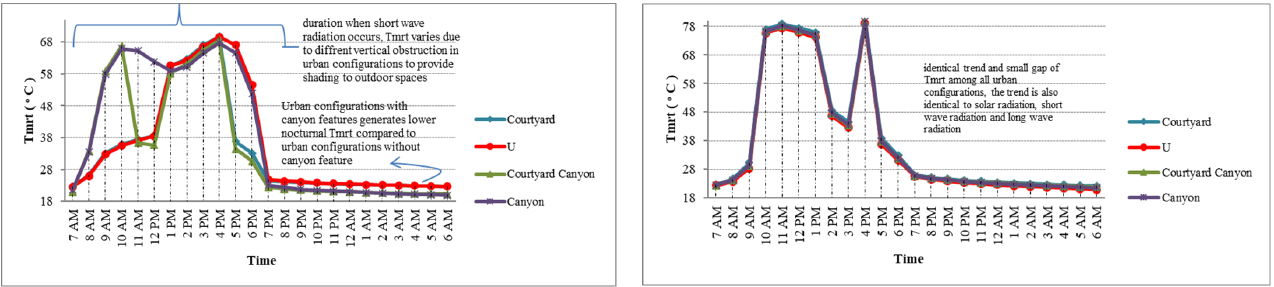
Figure 11. Mean radiant temperature vs. time at FBTS ( left ) and SM ( right ).